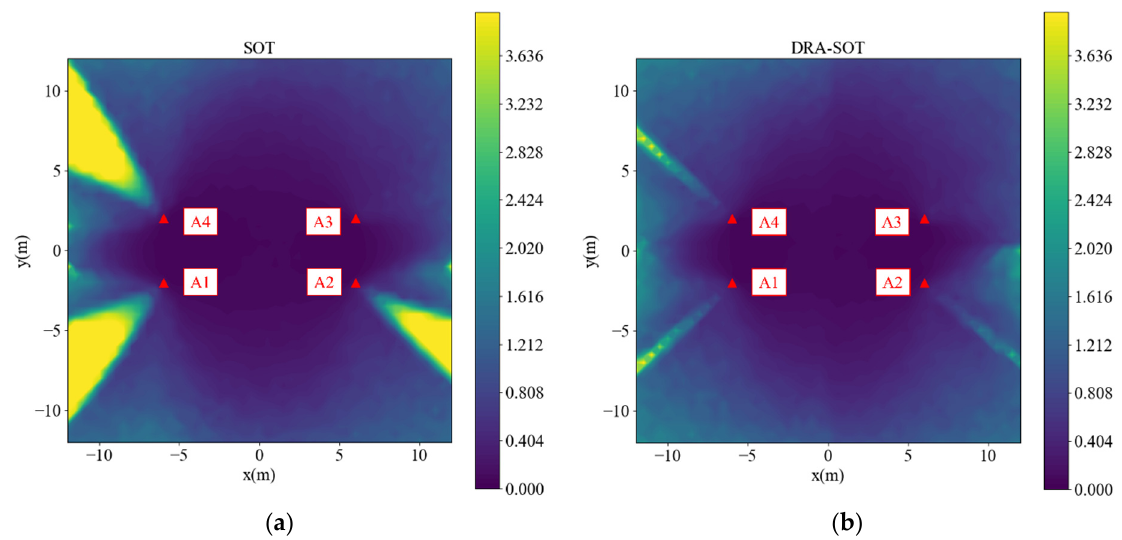
Figure 8. Simulated RMSE for rectangle deployment using ( a ) SOT, ( b ) DRA ‐ SOT.